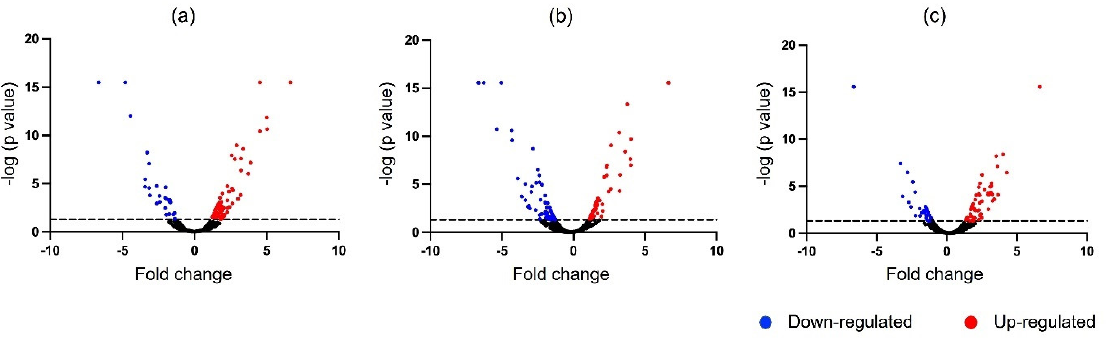
Figure 3. The volcano plot showed a pairwise comparison of mucus proteome for the identification of significant differentially expressed proteins ( p ≤ 0.05). ( a ) Control group versus resistant group; ( b ) control group versus susceptible group; ( c ) susceptible group versus resistant group. Table 2. Differentially expressed protein was found to be resistant when compared to the control.